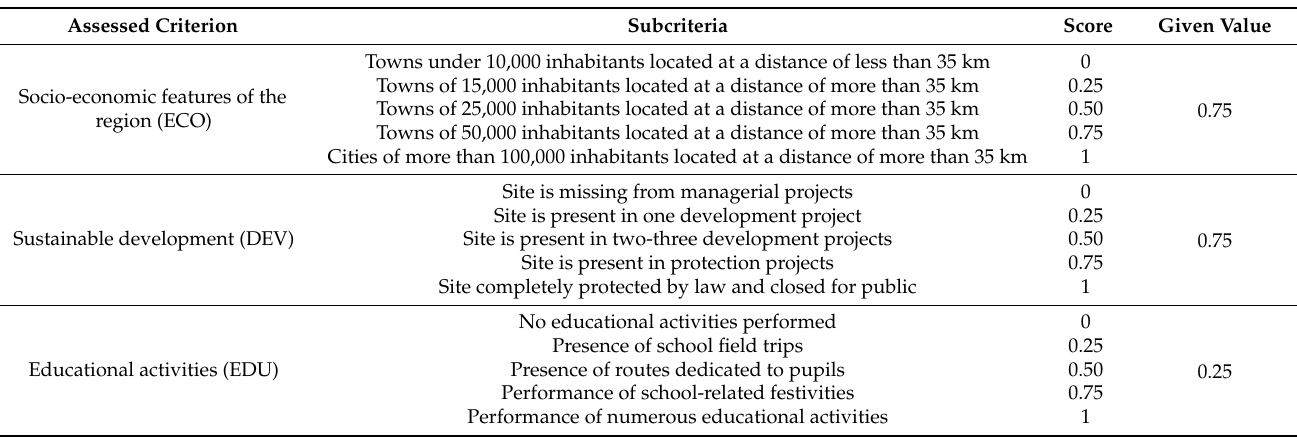
Table 6. Managerial aspects (V MNG